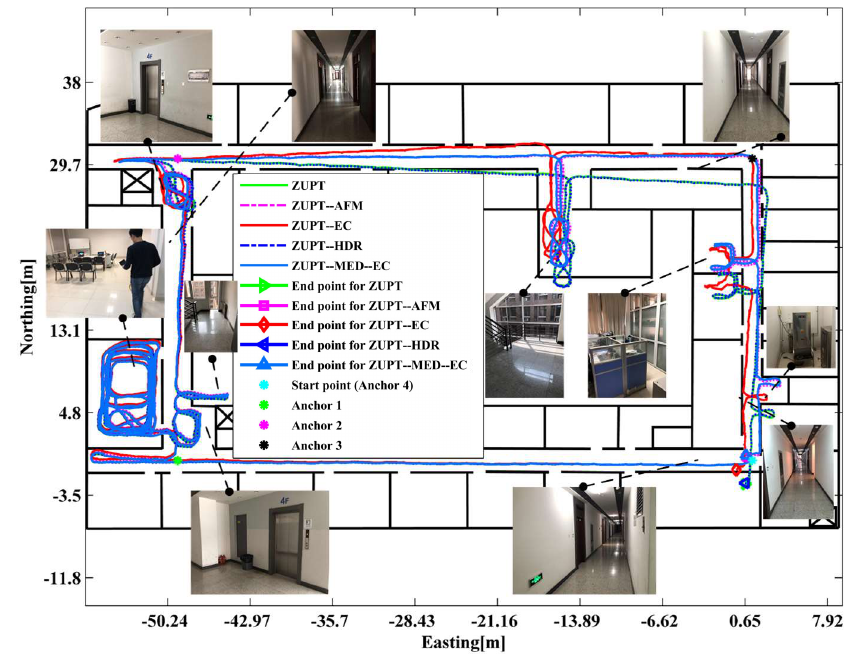
Figure 11. Estimated trajectories of different frameworks on the indoor free walking sub-dataset.